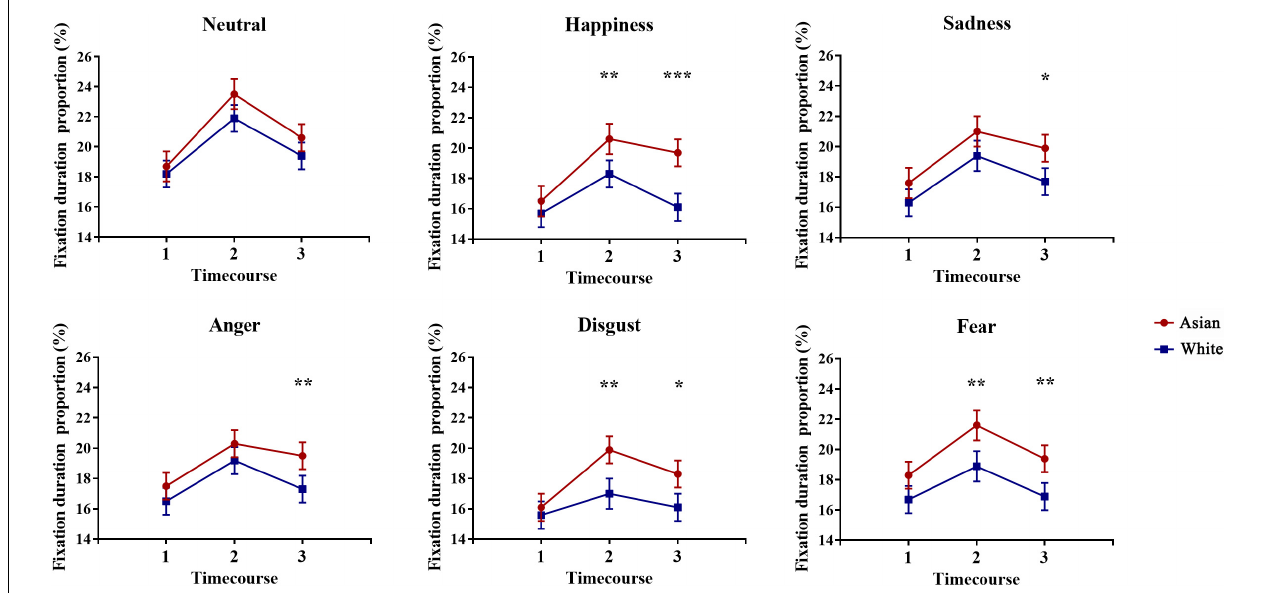
FIGURE 5 | Time course of fixation duration proportions on the eye region of Asian and White facial expressions. Duration of each emotional expression (Neutral, Happiness, Sadness, Anger, Disgust, and Fear) processing (i.e., 3,000 ms) was divided into three phases [(1) early: 0–1,000 ms, (2) middle: 1,000–2,000 ms, (3) late: 2,000–3,000 ms]. Lines represent mean fixation duration proportion across races (red-Asian; blue-White) at different time bins. Error bars represent standard errors of the means. * p < 0.05, ** p < 0.01, *** p < 0.001 for Asian vs.